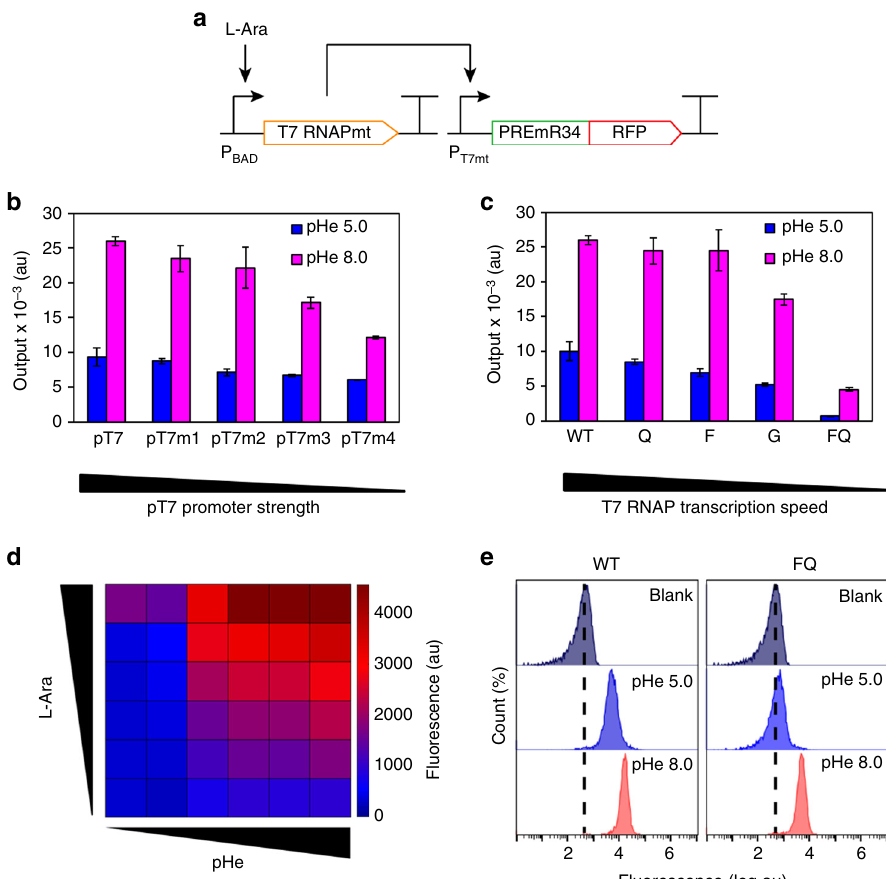
Fig. 2 Alleviation of the background leakiness of the pH-sensing device through transducer engineering. a Schematic of transducer engineering strategy involving the generation of T7 promoter mutants (pT7mt) and T7RNAP mutants (T7 RNAPmt). b Tuning the basal expression of the pH-sensing device through T7 promoter engineering. c Tuning the basal expression of the pH-sensing device through T7RNAP engineering. d Tuning the basal expression of the pH-sensing device through titration of the intracellular T7RNAP concentration. The heat map shows the graded fl uorescence output of the pH-sensing device controlled by the mutant FQ under varying L -arabinose induction (bottom to top: 0, 0.001, 0.002, 0.008, 0.02, 0.1% m/v) and extracellular pH (pHe) conditions ( left to right : 5.5, 6.0, 6.5, 7.0, 7.5, 8.0). e Comparing the output of the pH-sensing devices controlled by wild-type T7RNAP and the mutant FQ at L -arabinose induction 0.002% m/v. The data represent the mean of three independent experiments performed on different